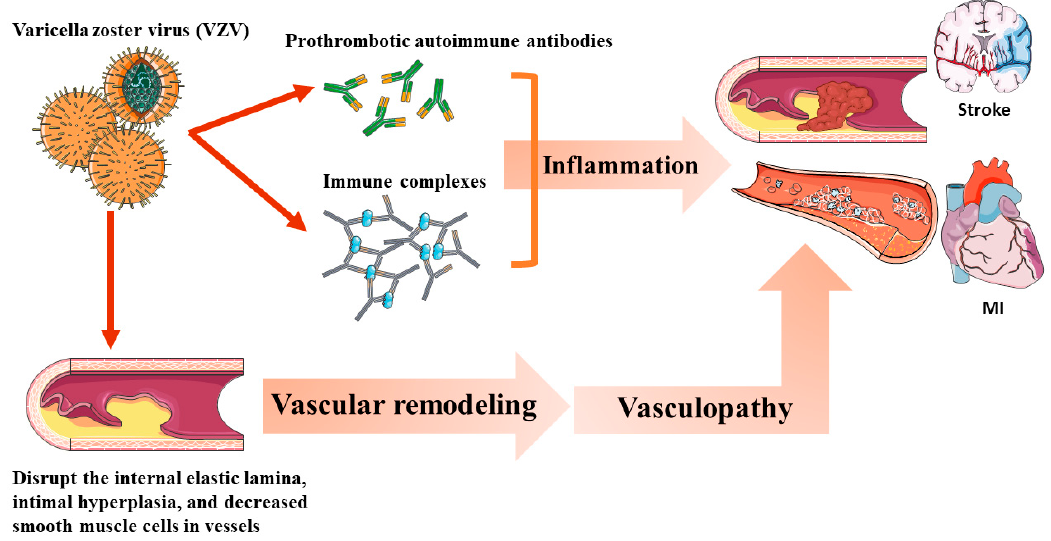
Figure 4. The potential mechanism of varicella zoster virus (VZV)-associated vascular events.